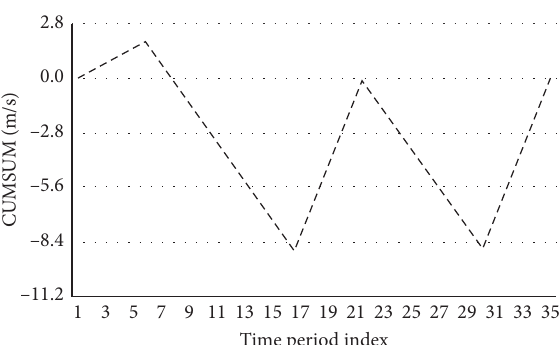
Figure 5: CUSUM chart of the second station